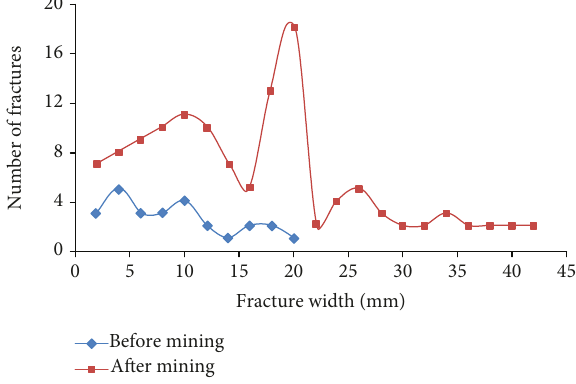
Figure 13: The variation of the number of cracks with the width of the fracture before and after mining.